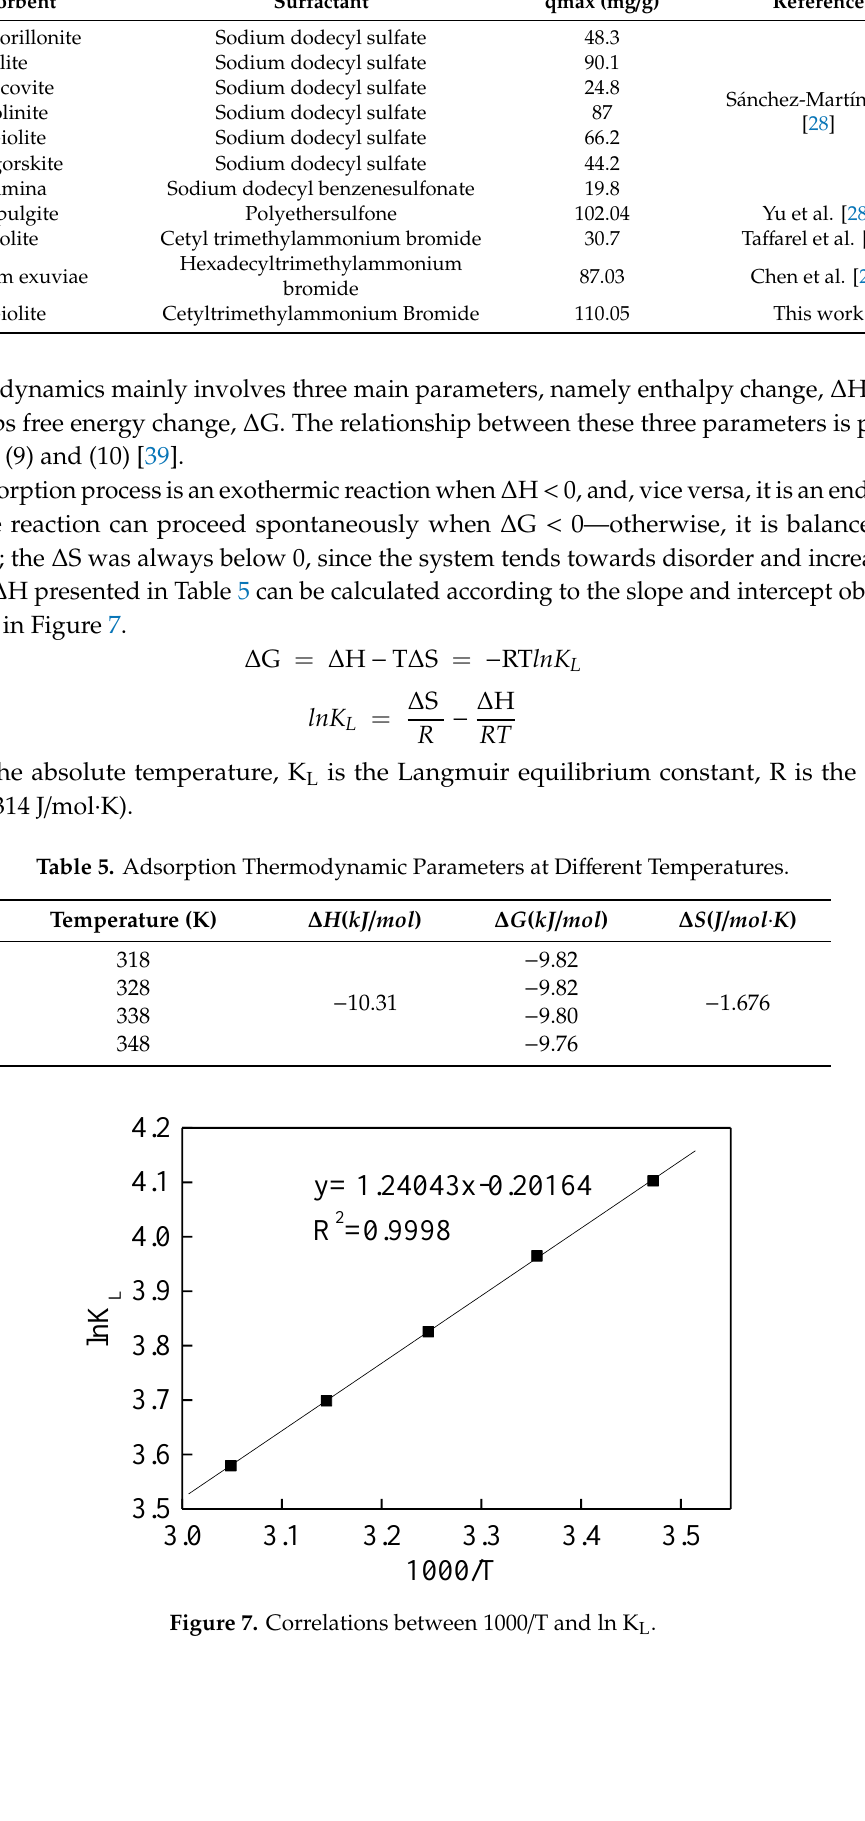
Table 4. Maximum Adsorption Capacity Comparison of Surfactant Adsorbent.